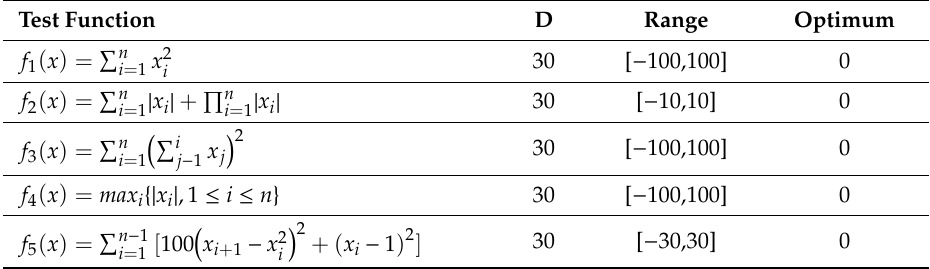
Table 2. High-dimensional benchmark functions used in Test